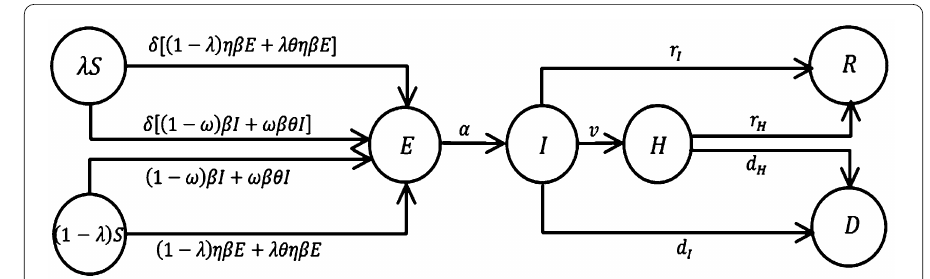
Figure 1 Diagram of transformation relationships of various compartments